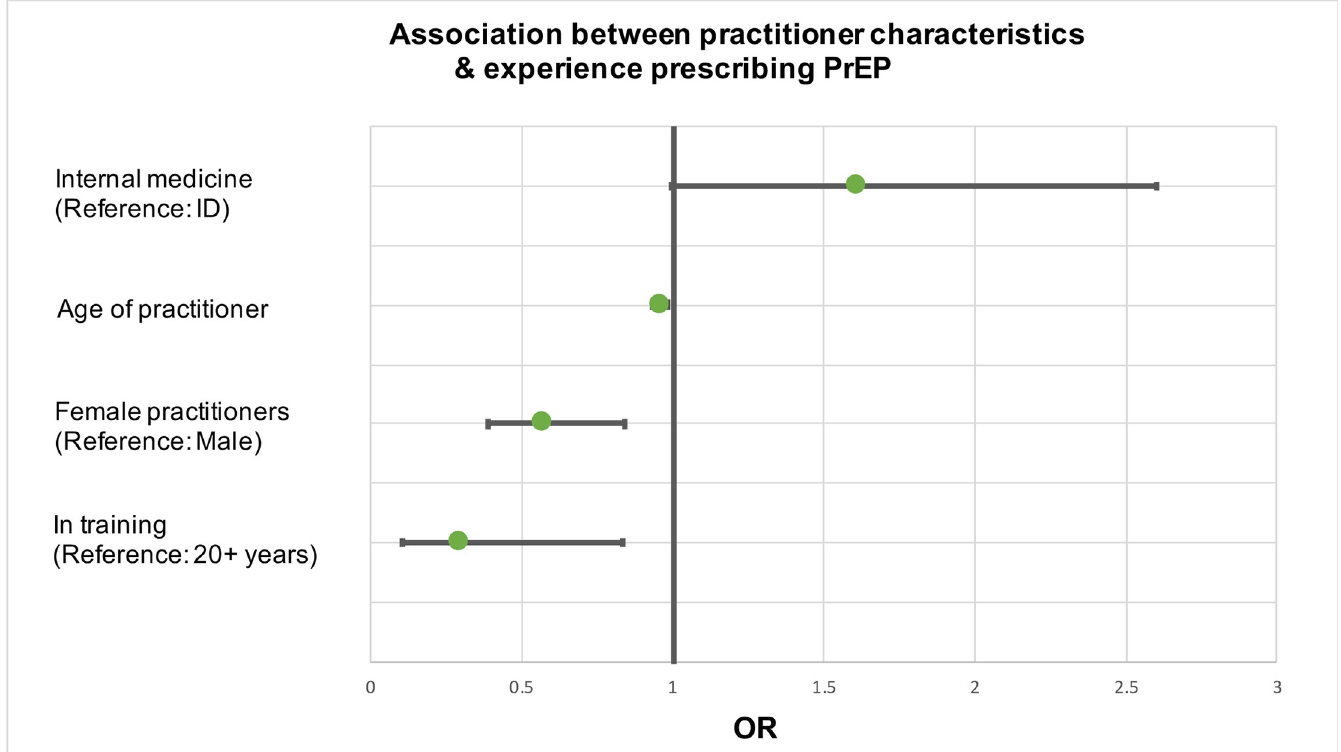
Fig 2. Multivariable logistic regression analysis on the association of practitioner characteristics and experience prescribing PrEP. This figure details the variables significantly impacting practitioner experience prescribing PrEP. ID = infectious disease.